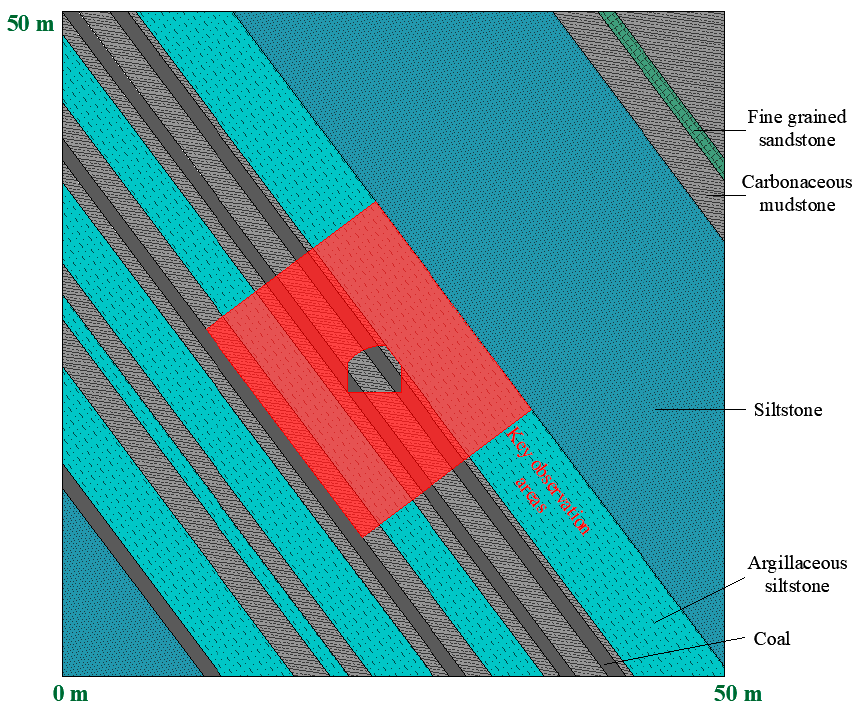
Figure 5. Model layout.